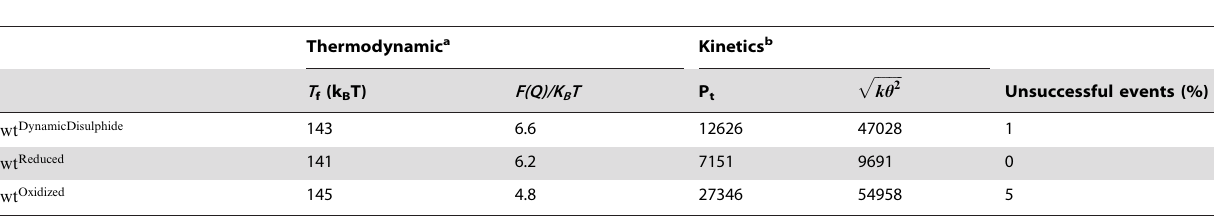
Table 1. Parameters explaining the thermodynamic- and kinetic properties of the three models obtained from C a simulations.